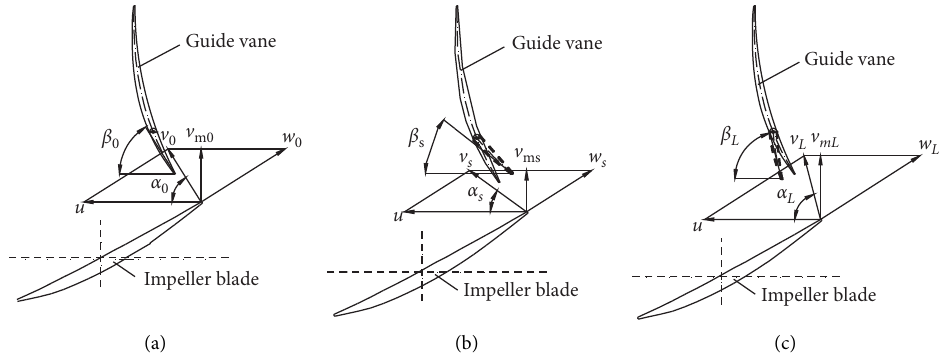
Figure 12: Matching relationships between the guide vane inlet angle and the impeller outlet flow direction. (a) Design discharge rate condition. (b) Smaller discharge rate condition ( α s < α